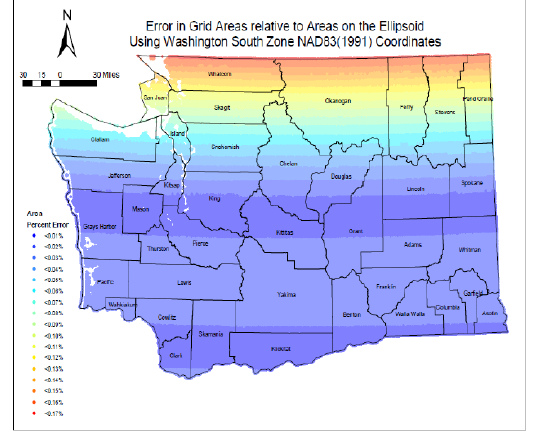
Figure 6: Error factor in area (maximum value +0.17%) for statewide use of Washington South Zone. Source: WAGIC, 2010)